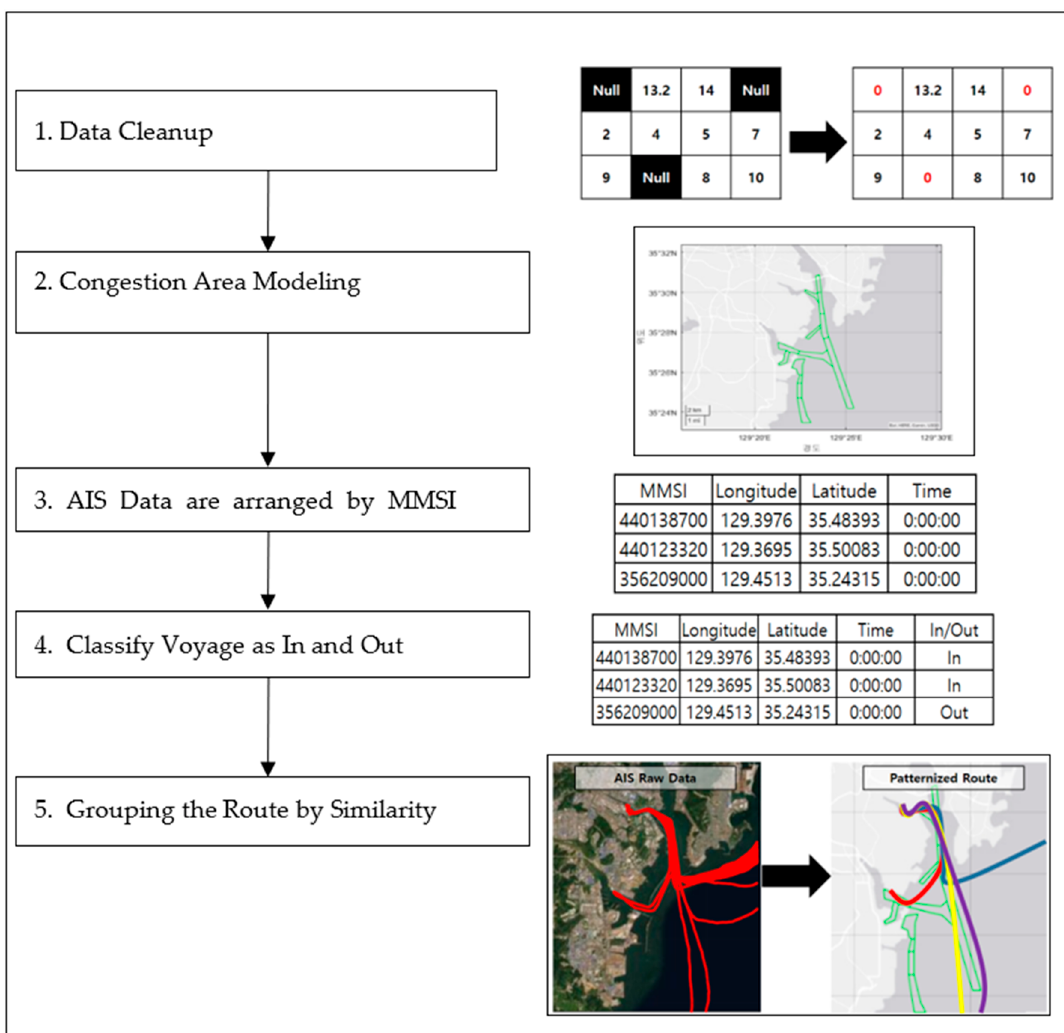
Figure 4. Flow of the data processing method.